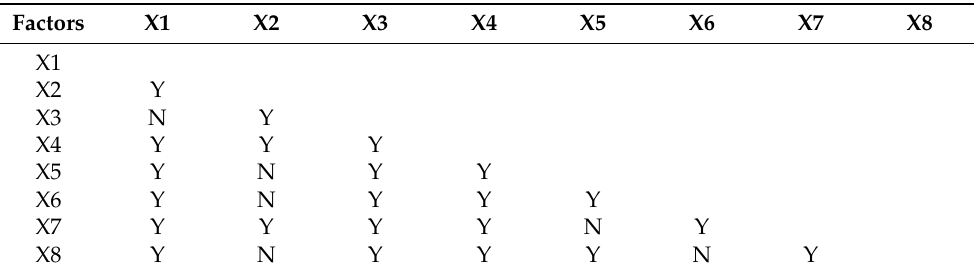
Table 5. Significant differences between